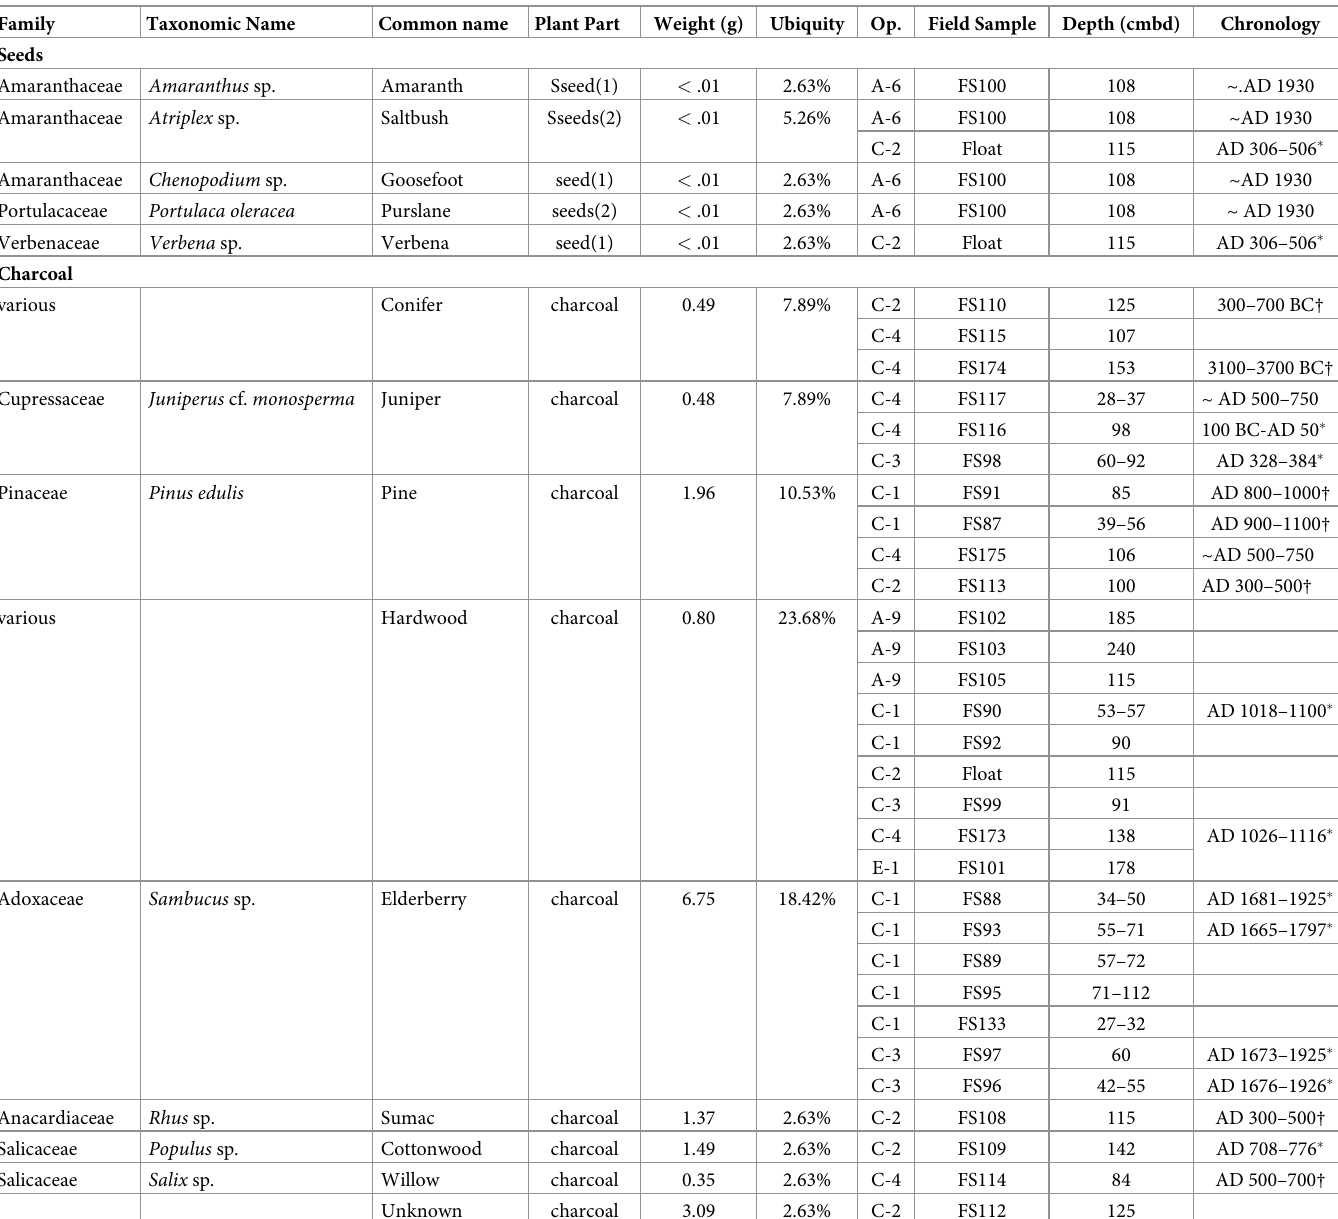
Table 1. Chaco Canyon macrobotanical remains from 2013–2015